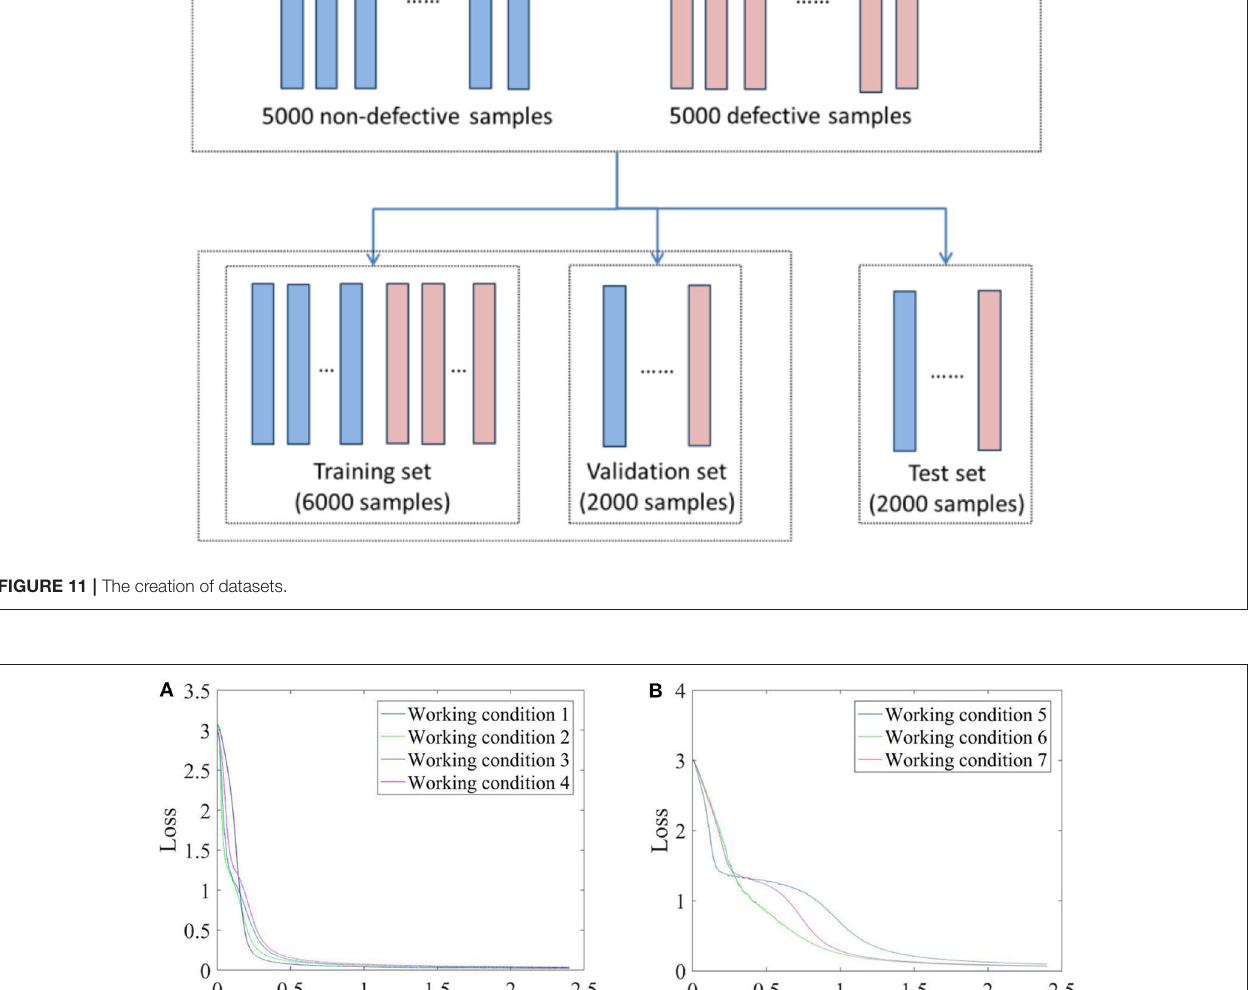
Frontiers in Materials |